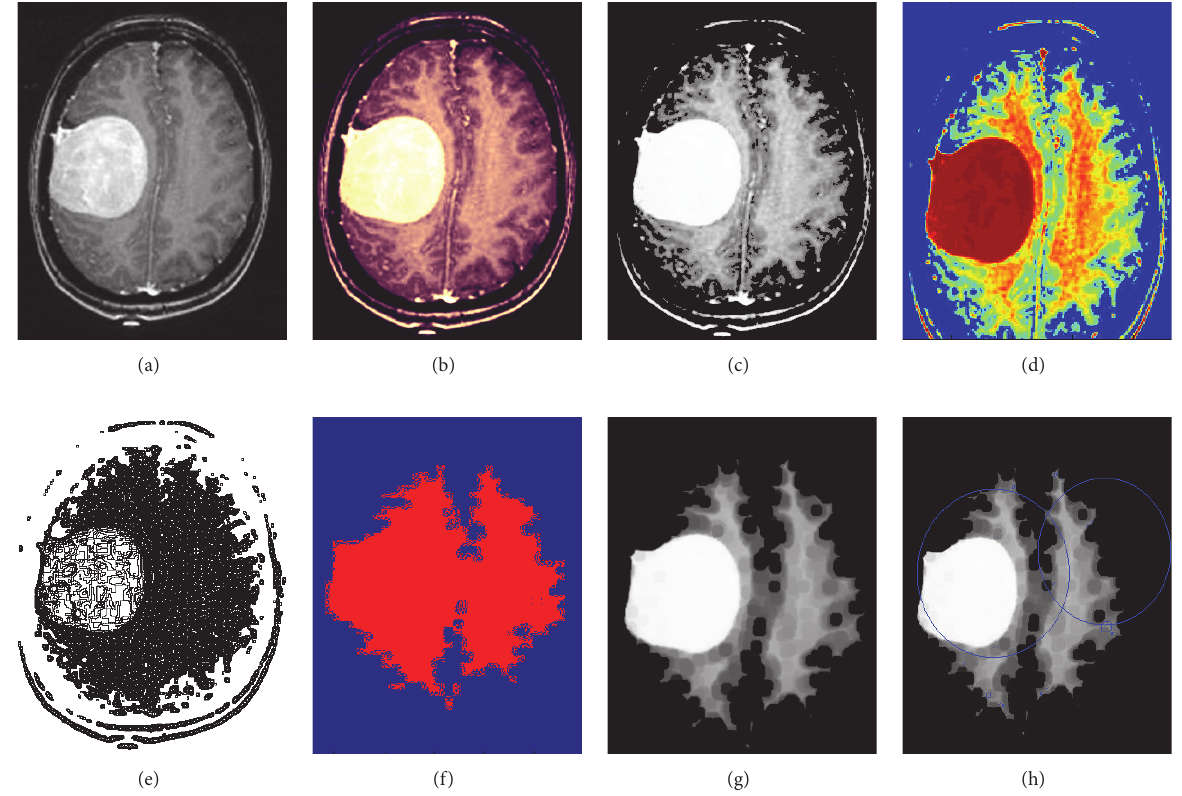
Figure 5: Experimental results of image 2. (a) Original image. (b) Enhanced image. (c) Skull-stripped image. (d) Wavelet decompose image. (e) Intense segmented image. (f) Dice overlap image. (g) Tumor region. (h) Area extracted tumor region.